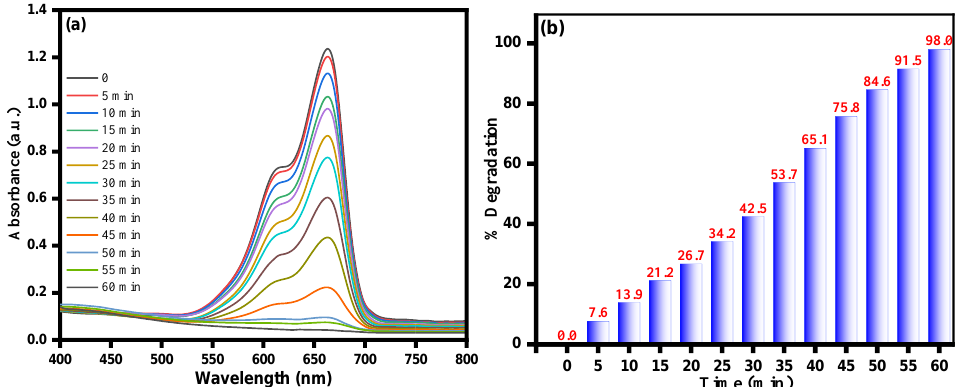
Figure 10. ( a ) UV-light absorbance against wavelength (nm) of MB molecules via ZnO–Ag nanocomposite and ( b ) the percentage degradation of MB molecules via ZnO–Ag nanocomposite against time (min) at different intervals.